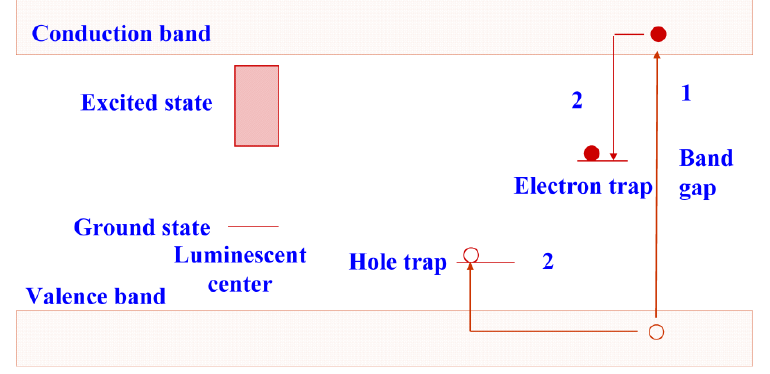
Figure 2. Energy diagram showing electron and hole trapping in a storage